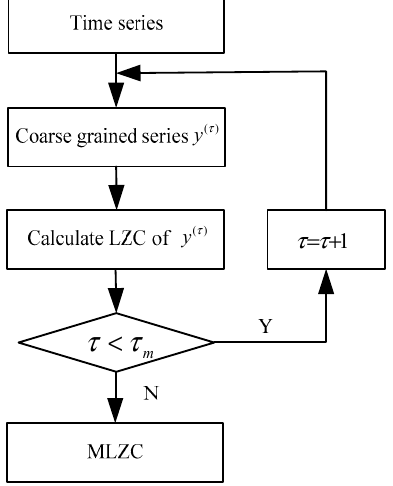
Figure 2. The flowchart of multi-scale Lempel-Ziv complexity (MLZC).